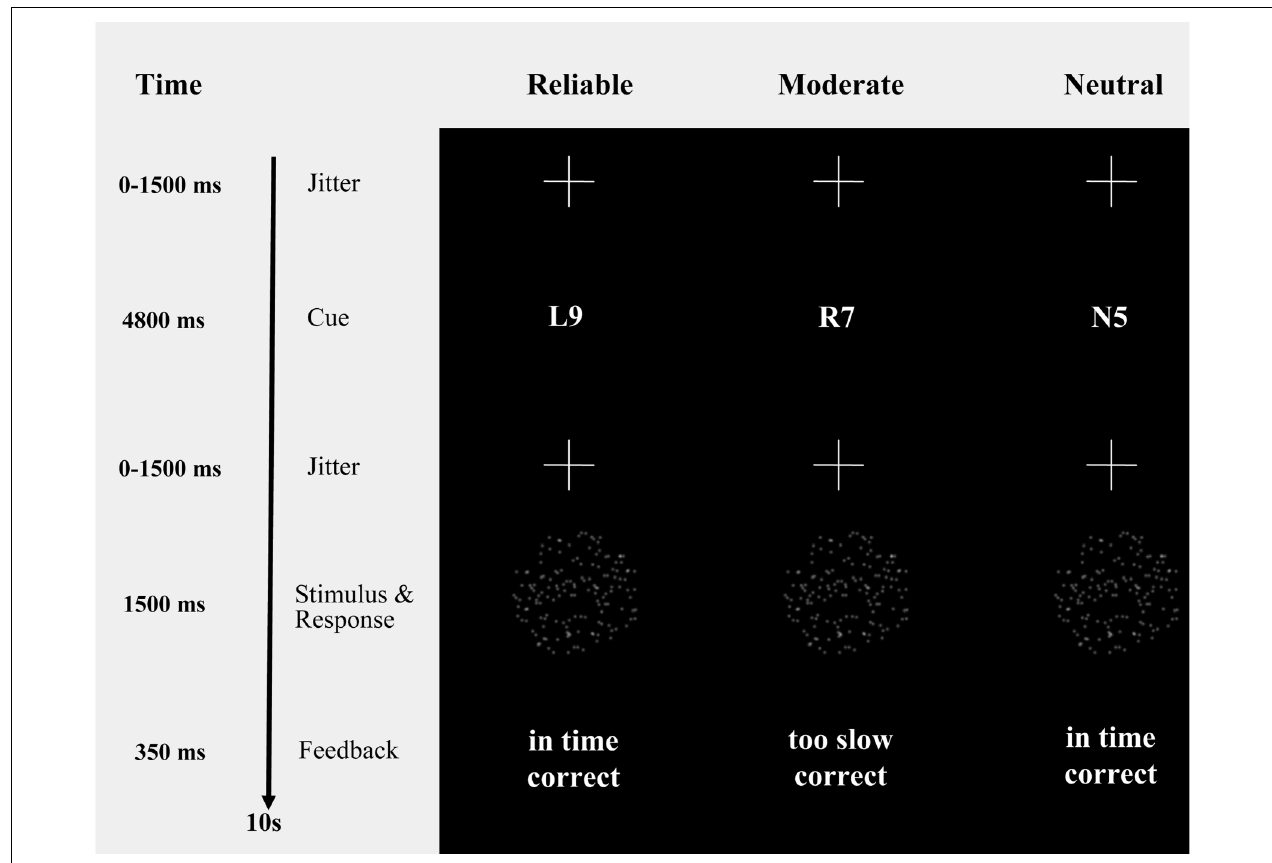
moderate cues, indicating a 70% chance of rightward or leftward movement, respectively; “N5”, neutral cue, indicating that leftward and rightward movement are equally probable). The timing information refers exclusively to the fMRI